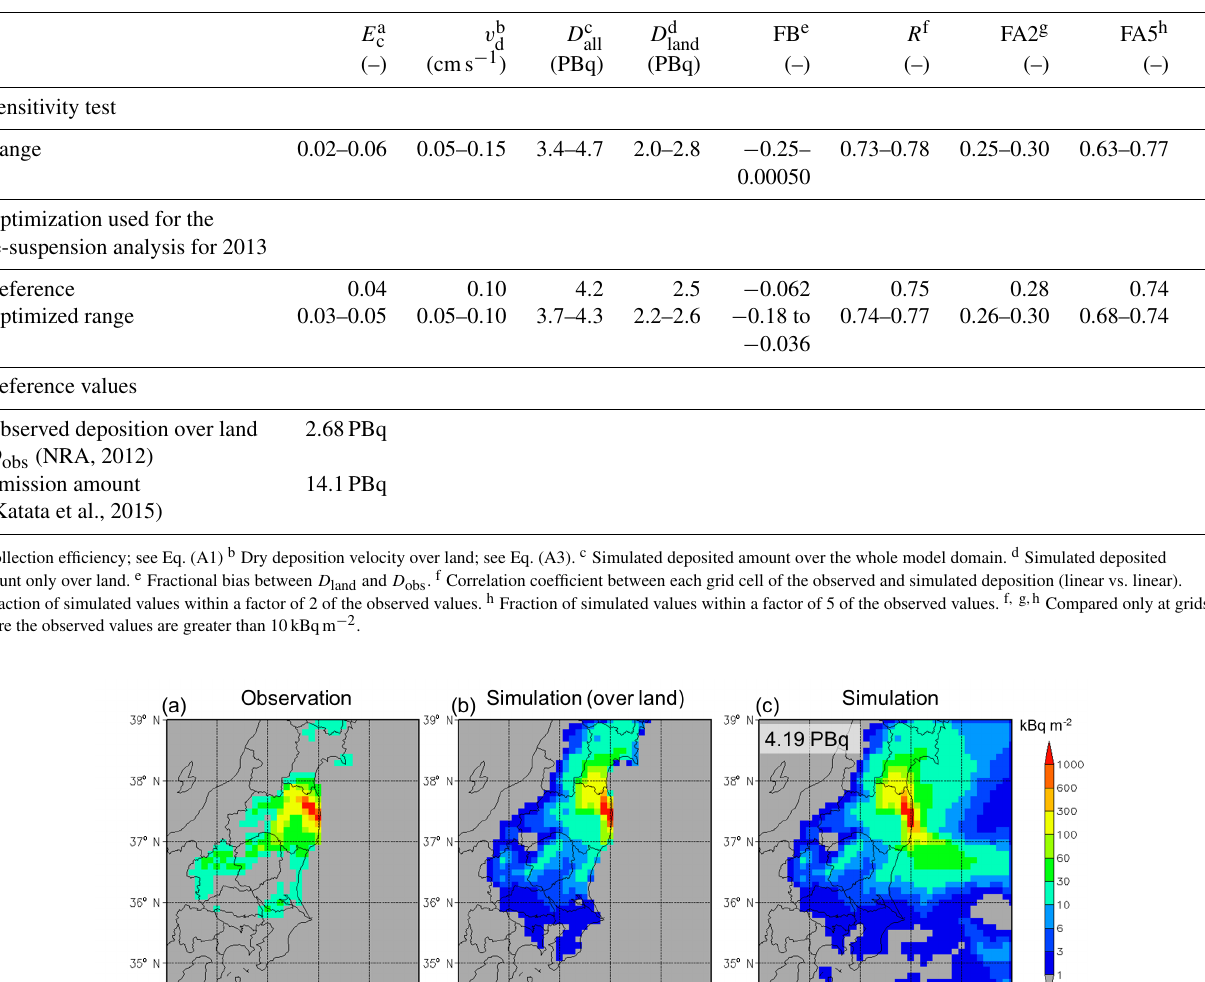
ranges − 0.18 to − 0.036, 0.74–0.77, 0.26–0.30,